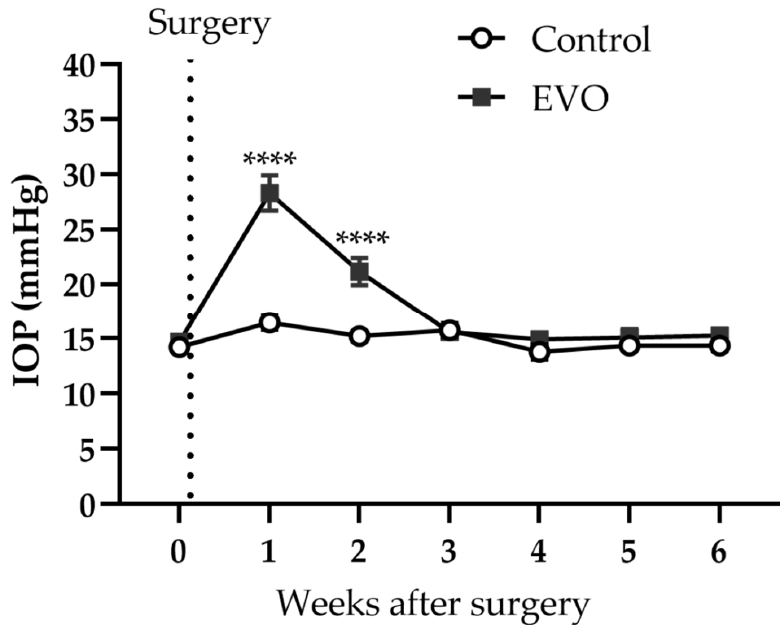
Figure 1. Follow up of IOP throughout the whole experiment. EVO increased IOP for two weeks. Control group refers to the sham group. Values are expressed as mean ± SEM (**** p < 0.0001; n = 8 per group).